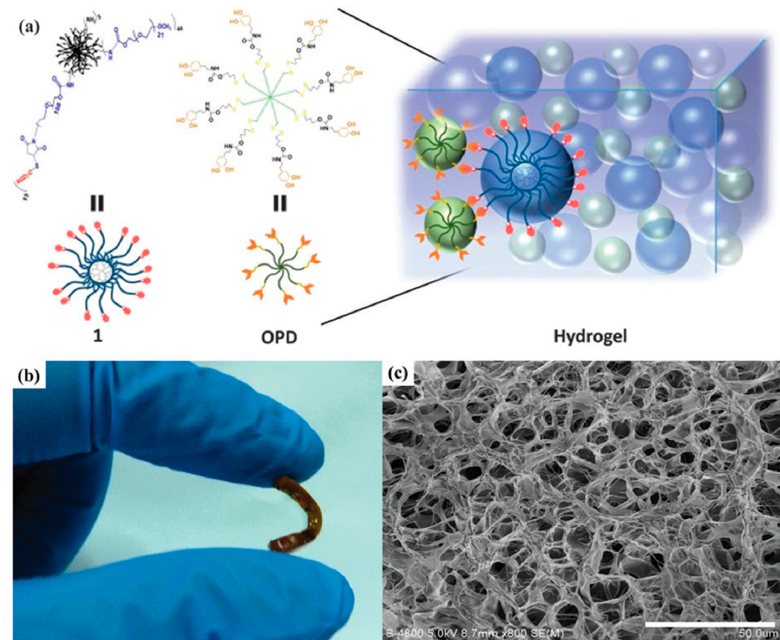
Figure 24. ( a ) Formation of hydrogel-based on the RGDyC-modified PEGylated PAMAM dendrimer and DOPA-terminated eight-armed PEG (OPD); the photograph ( b ) and SEM image ( c ) of the hydrogel. Reproduced from [54] with permission of The Royal Society of Chemistry.